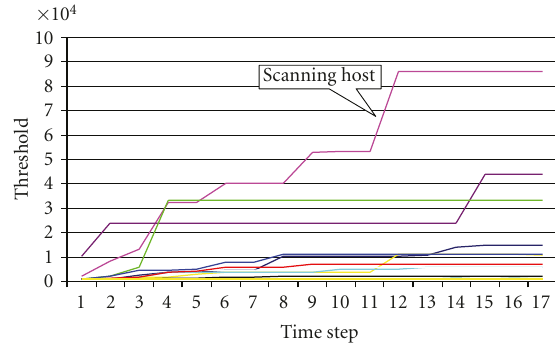
Figure 5: USC tra ffi c threshold analysis (clean).